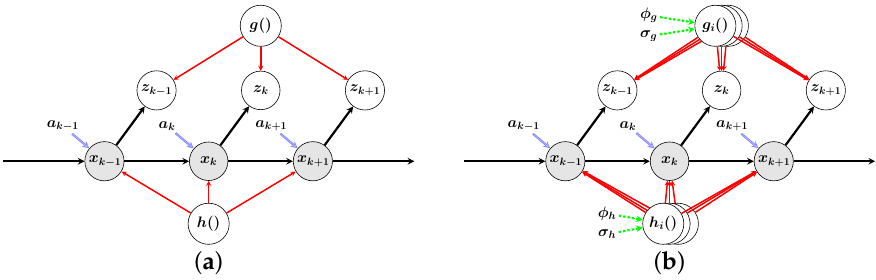
Figure 2. Graphic explanation of the Gaussian process (GP) state-space inference and distributed hidden-state identification. Derived from the distributed GP framework, the hidden state variables (embedded in the gray circles) are identified by the dynamic models h i () and the measurement models g i () , separately. Also, the connection is presented in the red arrows and the influence of the input to the control plant is shown in the blue arrows. Note that the hyper-parameters φ h , σ h related to the dynamic models are shared in the training process (in green arrows), along with the hyper-parameters φ g , σ g for measurement models. ( a ) GP state-space inference; ( b ) proposed distributed hidden-state